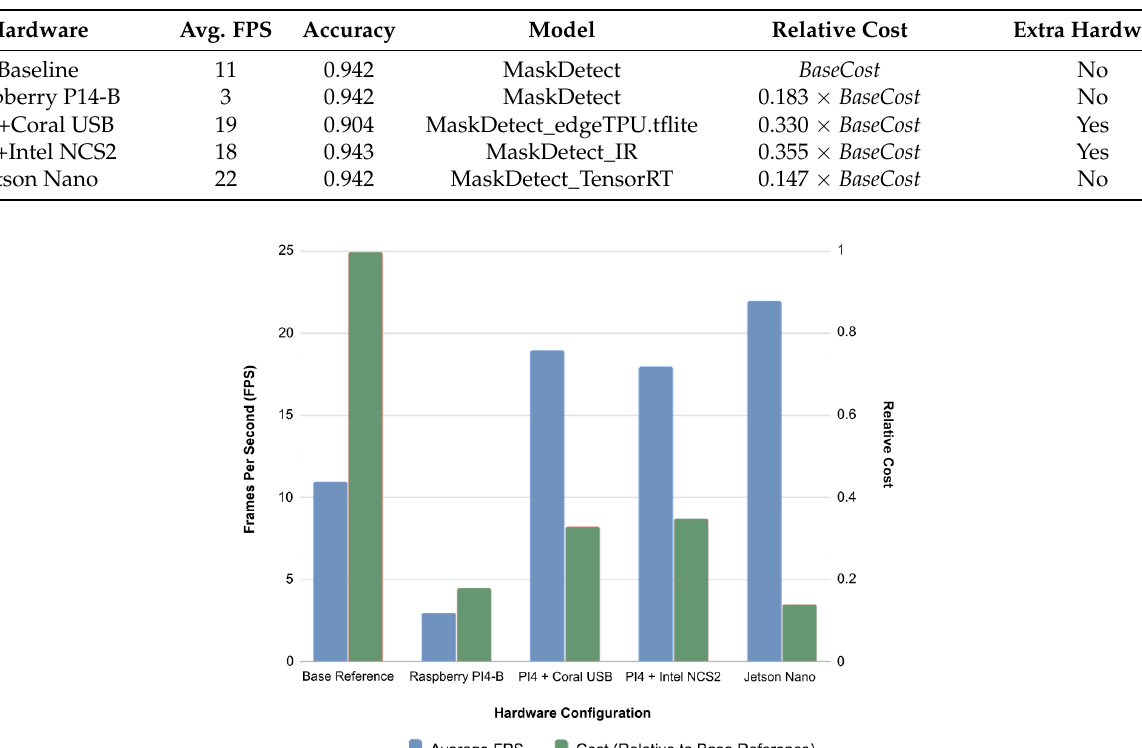
Table 3. Performance analysis of various implementations of MaskDetect regarding computa- tional platforms.